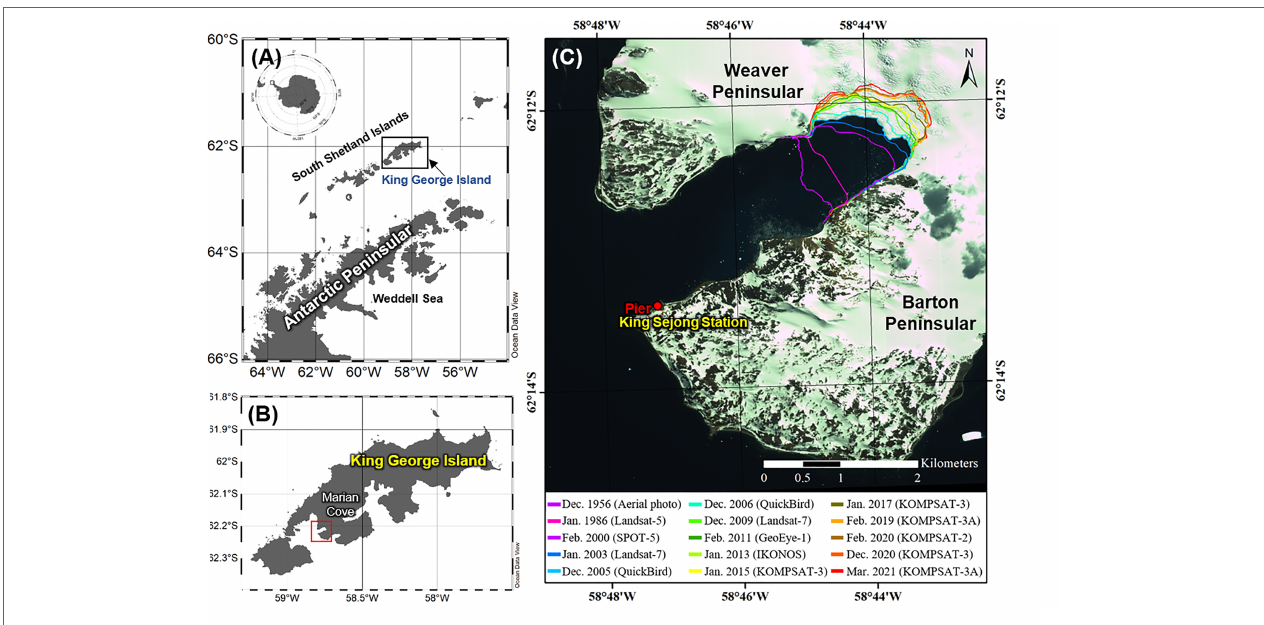
FIGURE 1 | Map showing the location of the (A) South Shetland Islands, (B) King George Island, and (C) Marian Cove. Glacier termini overlaid on remote sensing images and aerial photographs acquired in 1956-2021. The maps (A , B) were generated by using Ocean Data View v. 5.3.0 (https://odv.awi.de) (AWI, Bremerhaven, Germany, Schlitzer,